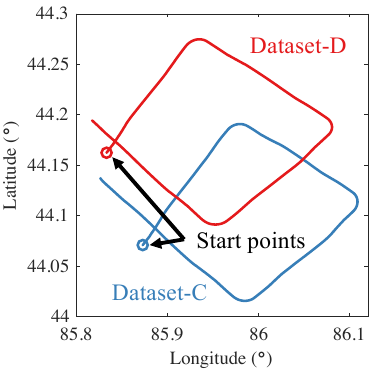
Figure 8. The tracks of Dataset-C and Dataset-D.